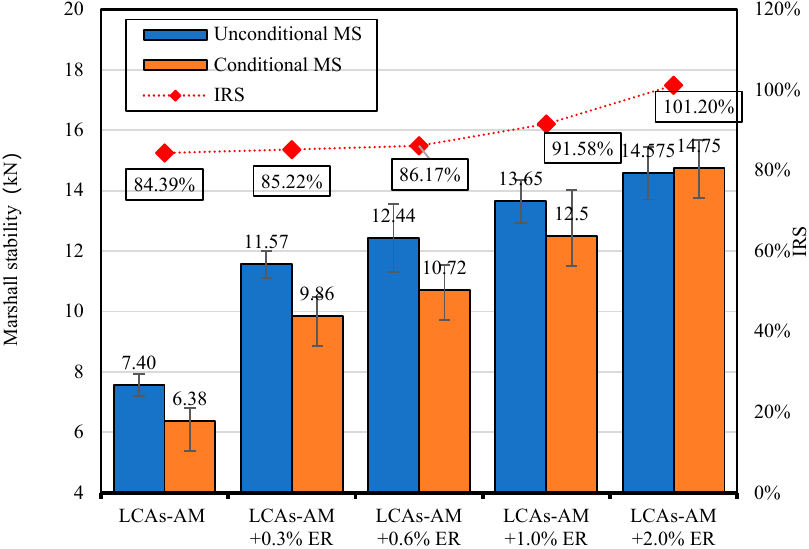
Figure 11. Immersion Marshall stability and RMS of LCA-AMs with ER.